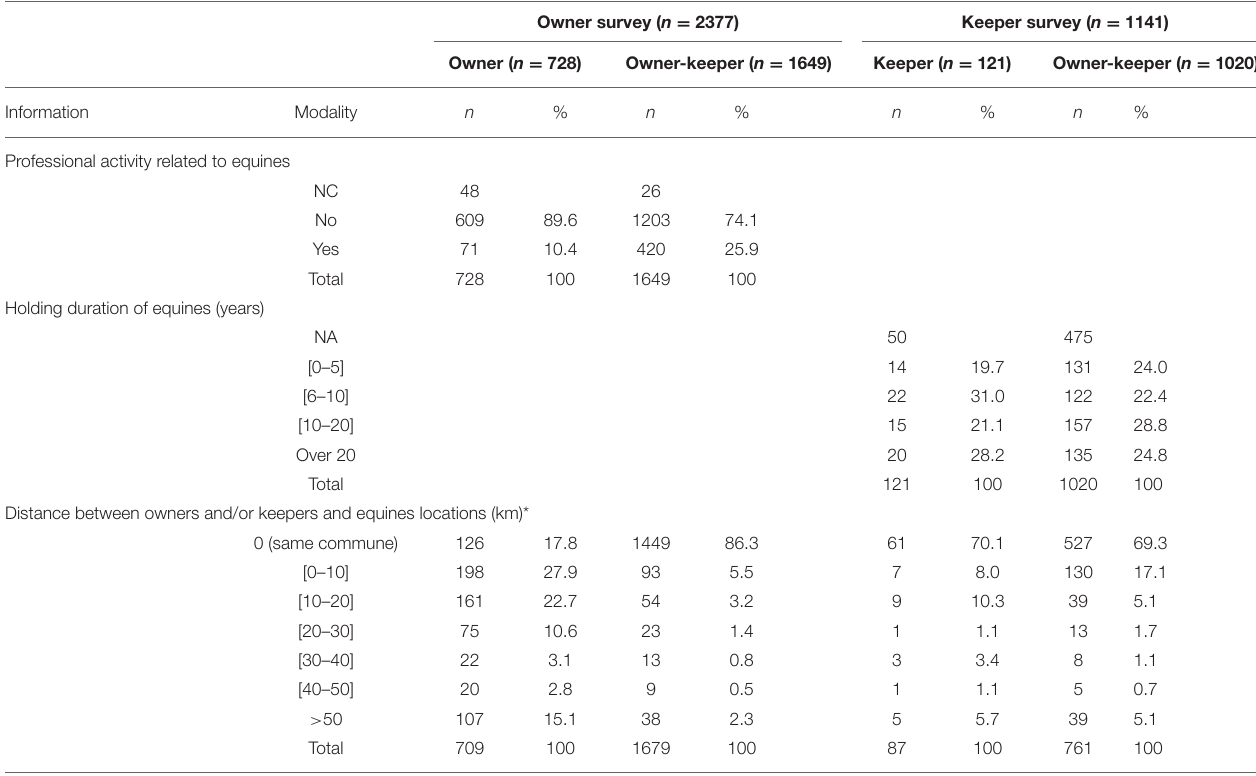
TABLE 1 | Major characteristics of respondents by type of respondent (owner, owner–keeper, or keeper, professional activity and holding duration) and distance between respondent and equines